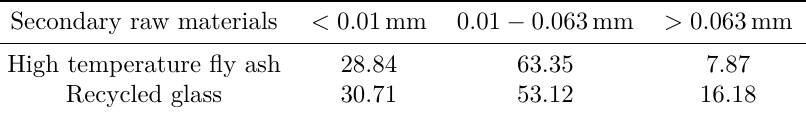
Table 2. Grain size of substitution binders